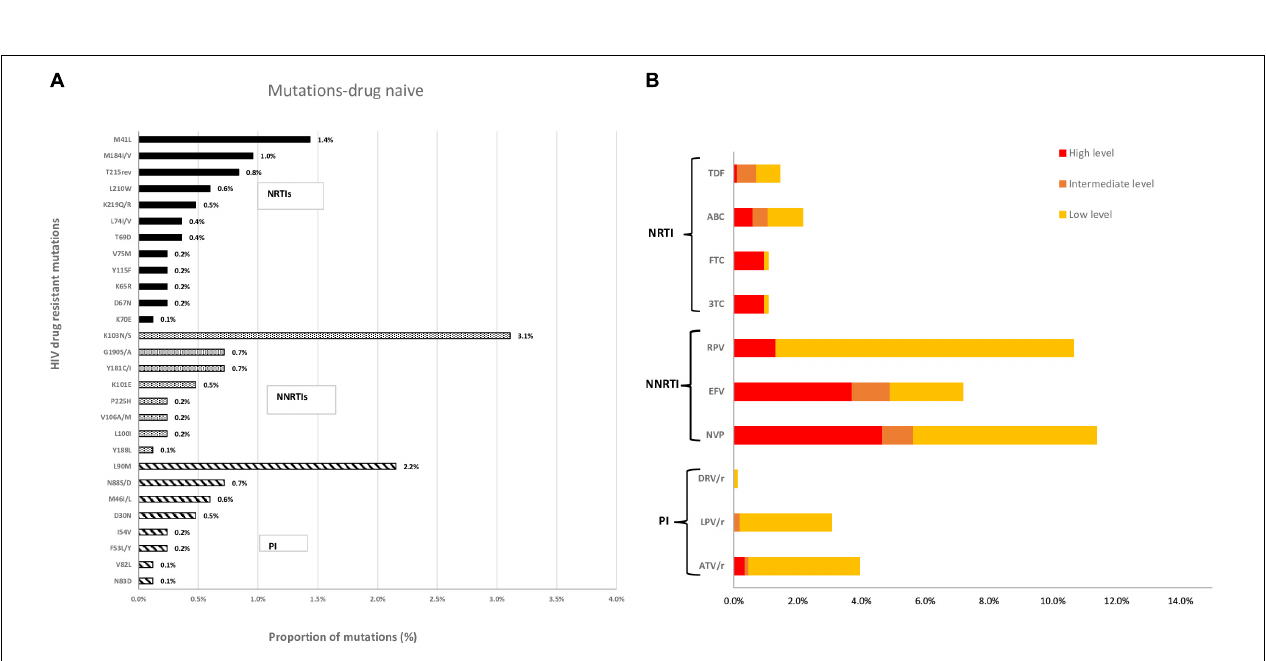
FIGURE 2 | (A) Proportion of resistance mutations in the sequences of newly diagnosed patients and (B) Predicted phenotypic resistance (Stanford scores) to antiretroviral drugs currently recommended as first-line therapy in Portugal for newly diagnosed patients (2014–2019). NRTI, Nucleoside reverse transcriptase inhibitor; NNRTI, Non-nucleoside reverse transcriptase inhibitor; PI, Protease inhibitor; FTC, Emtricitabine; TDF, Tenofovir; 3TC, Lamivudine; ABC, Abacavir; EFV, Efavirenz; RPV, Rilpivirine; DRV/r, Darunavir; LPV/r, Lopinavir; ATV/r, Atazanavir. Scores of low-level (score 2 and 3), intermediate-level (score 4), or high-level (score 5) resistance were used to predict phenotypic